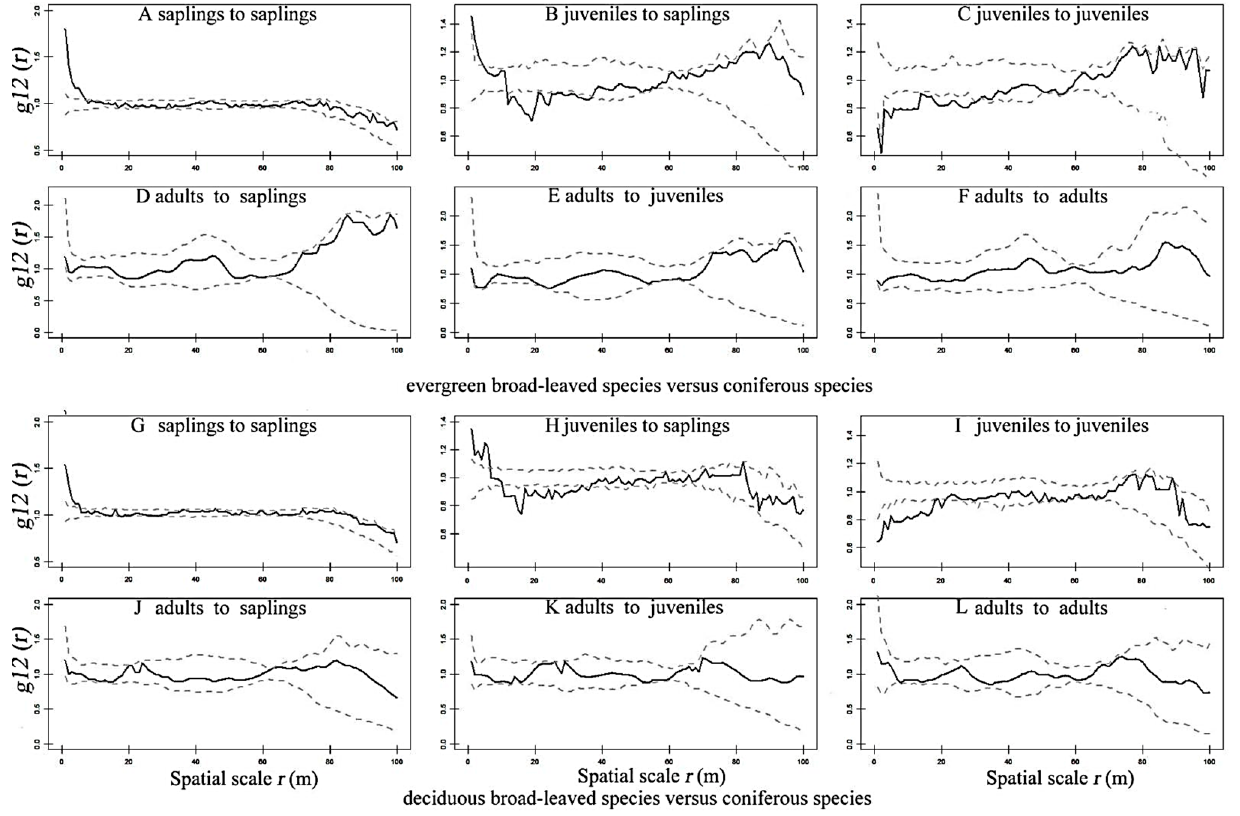
Figure 5. Spatial associations of broad-leaved species and coniferous species among different DBH classes in the mixed forest community The 99% confidence interval is indicated by dotted lines and the g12(r) function is in black. Observed values below the lower limits represent a negative association, values above the upper limits mean positive association, and values within the intervals mean there is no association. ( A , G ) saplings to samplings; ( B , H ) juveniles to saplings; ( C , I ) juveniles to juveniles; ( D , J ) adults to saplings; ( F , L ) adults to adults.